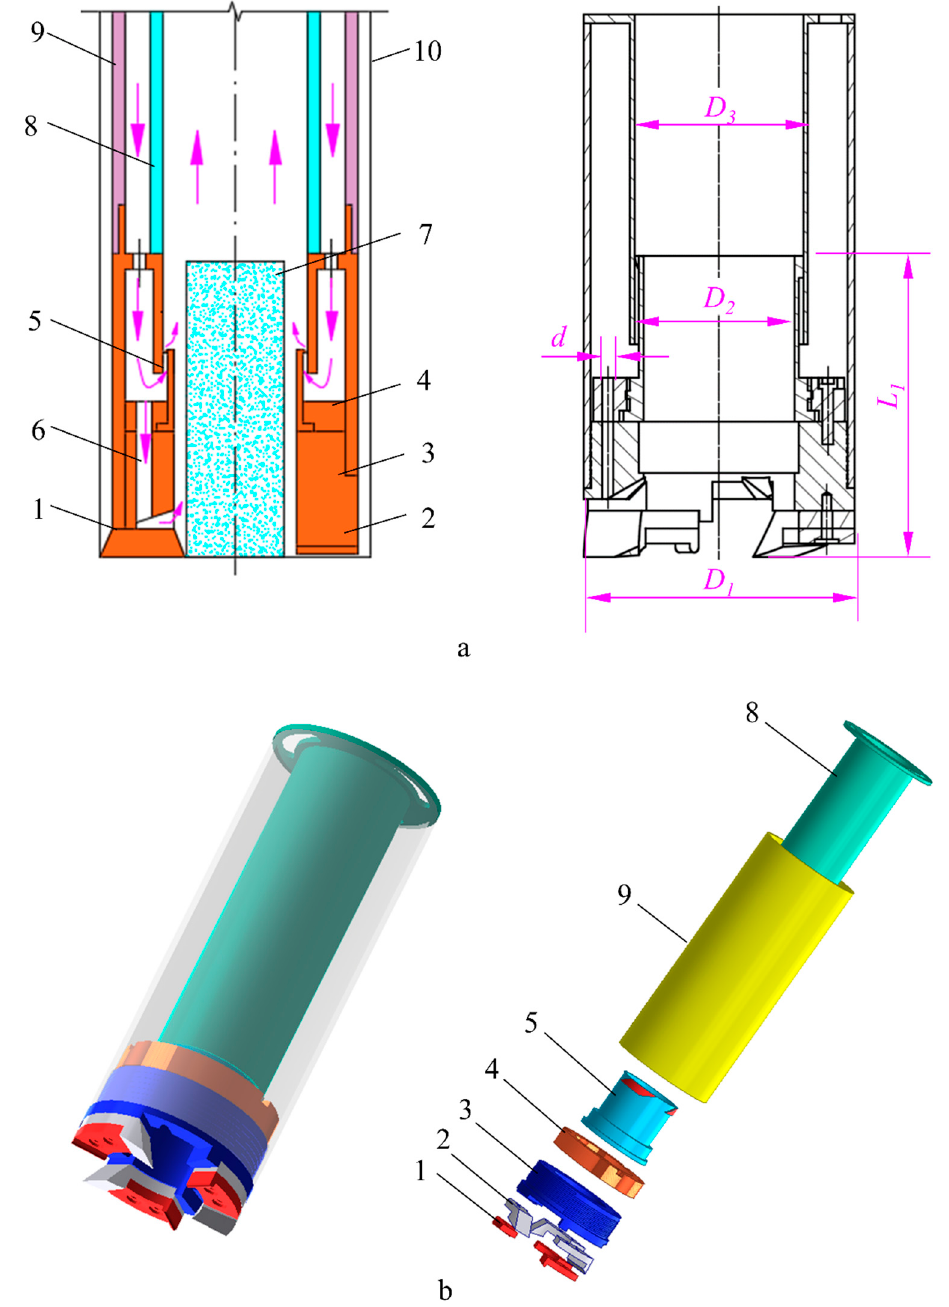
Figure 1. Swirling ice core drill bit: ( a ) working principle of the swirling drill bit; ( b ) 3D models: (1) cutters; (2) shoes; (3) lower drill bit body; (4) upper drill bit body; (5) swirler; (6) flushing nozzles; (7) ice core; (8) inner tube of drill bit; (9) outer tube of drill bit; (10) borehole wall. Table 1. Structural parameters of the swirling drill bit.